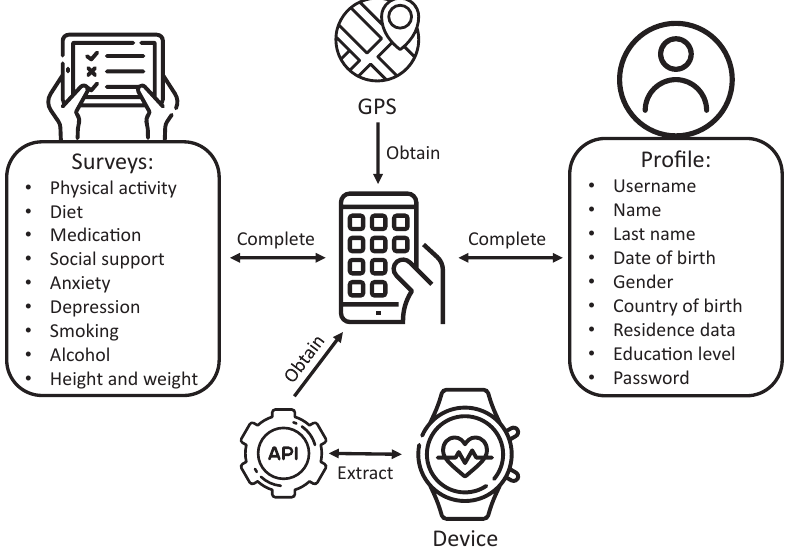
Figure 3. Data dimensions acquired by the smartphone